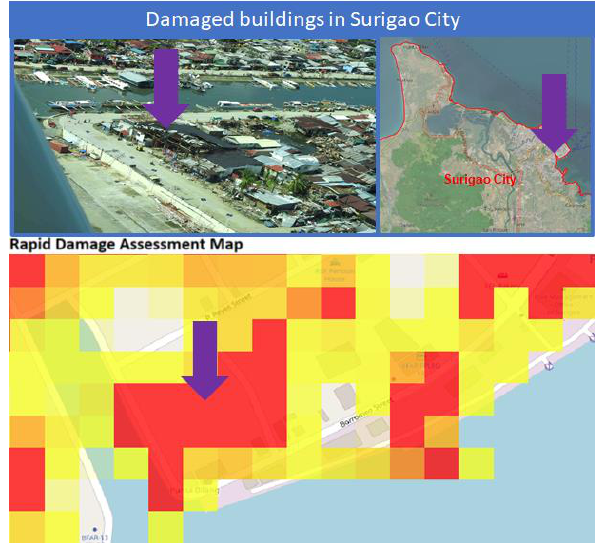
Figure 7. Rapid damage assessment maps at General Luna National High School, Siargao. Bounding boxes indicate potentially damaged roofs and buildings in the campus. Basemap © OSM 2022.